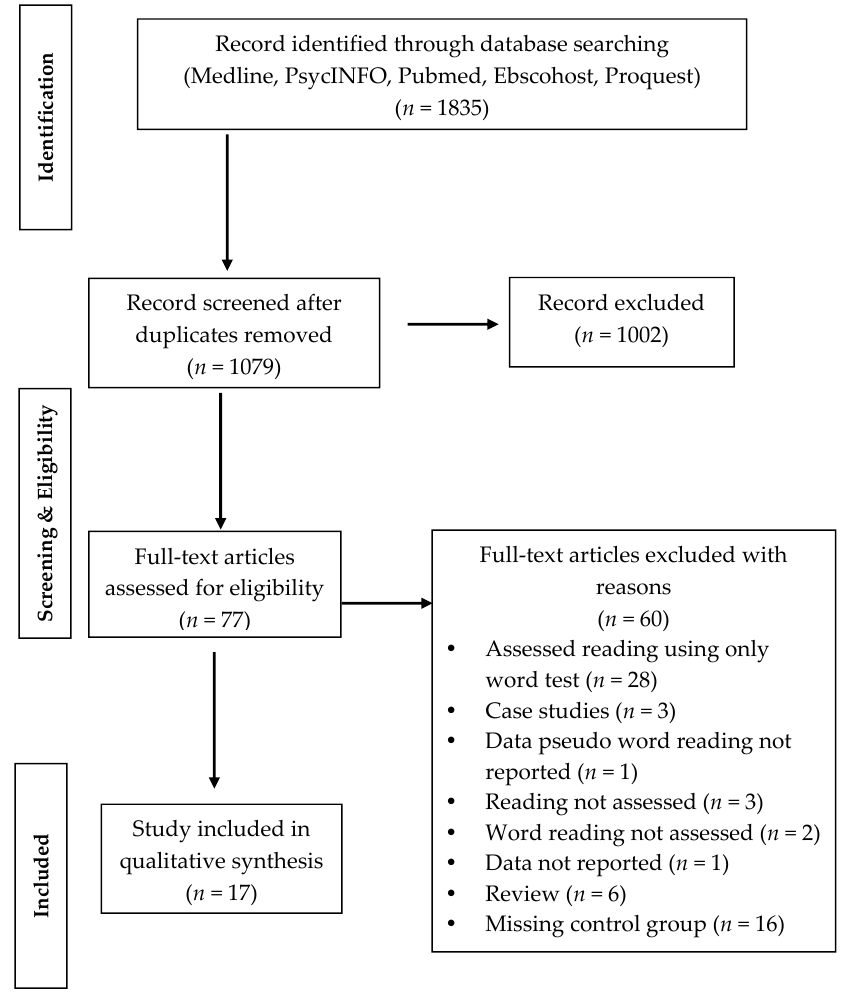
Figure 1. Flow diagram of selection process of studies.